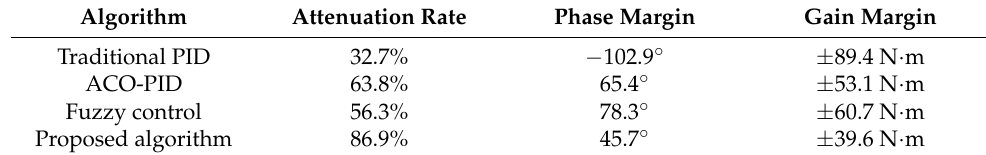
Table 2. Evaluation results of vehicle steering control effect under different control